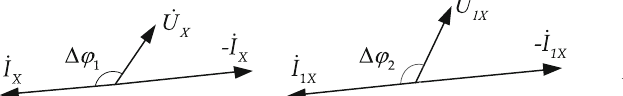
Fig. 5 The pre- and post-fault current and voltage vector graphs of X terminal of situation (2)